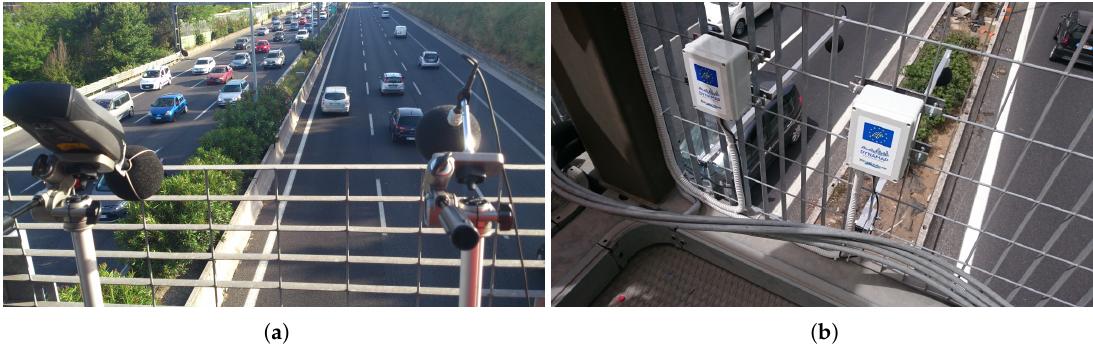
Figure 2. Location of the sensor used in the recording campaign in the portals. ( a ) Recording campaign deployment in [23]; ( b ) WASN deployment in this work (picture property of ANAS